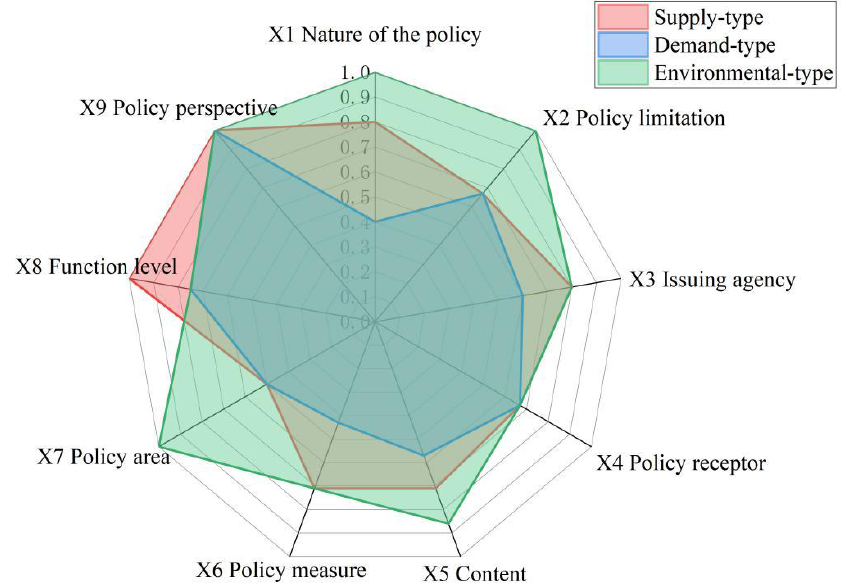
Figure 5. Radar chart of PMC index of three types of policy tools for the wind power industry.